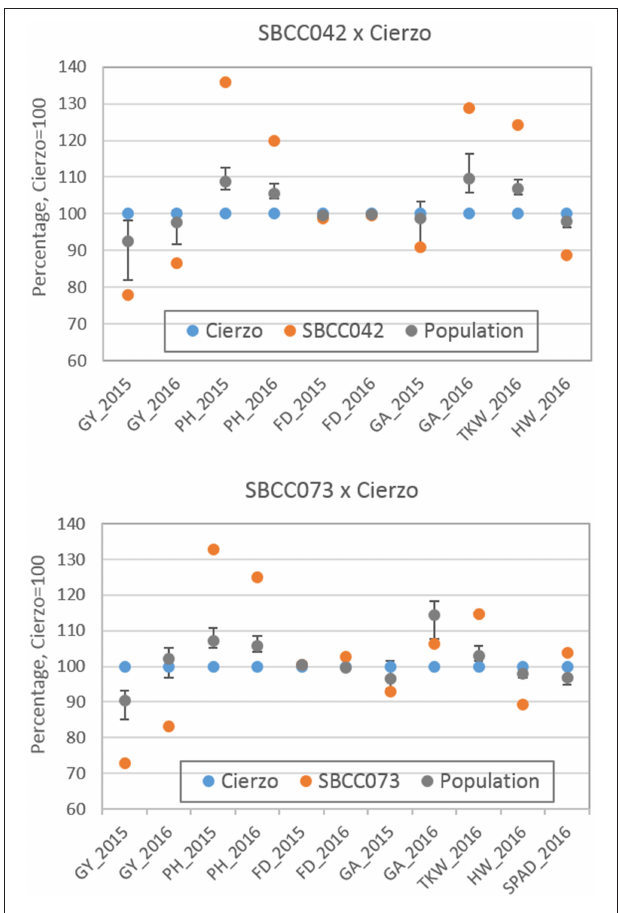
FIGURE 1 | Schematic representation of trait averages for the two BC 2 F 5 barley populations, compared to those of their parents, showing the least significant differences ( P = 0.05) of the population average against each parent. The elite parent Cierzo was given a value of 100 for each trait, and other averages and LSDs were calculated relative to